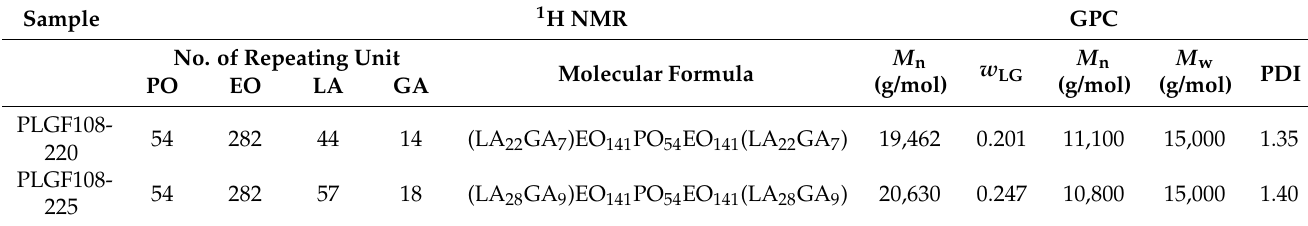
Table 1. Characterization of pentablock copolymers used as a template a